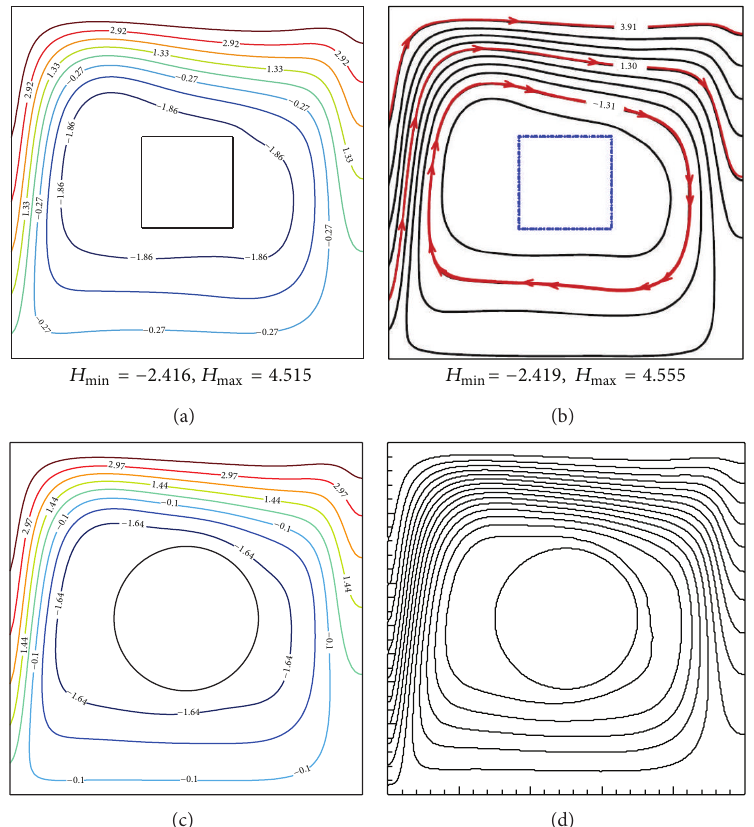
Figure 2: Comparison of the present computed heatlines (a, c) against that of Zhao et al. [5] for quadrilateral, 𝑁 = 4 (b) and Costa and Raimundo [12] for cylinder, 𝑁 = ∞ (d) at Ra = 10 5 , 𝑋 0 = 0.5 , and 𝐾 𝑟 = 1 .